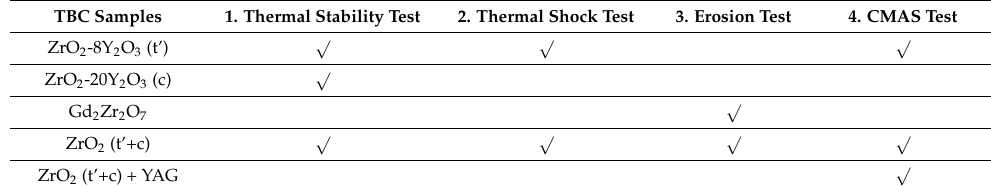
Figure 3. SEM images of the cross-section microstructures of the two-phase composite TBC: ( a ) as- sprayed TBC; ( b ) as-sprayed topcoat.